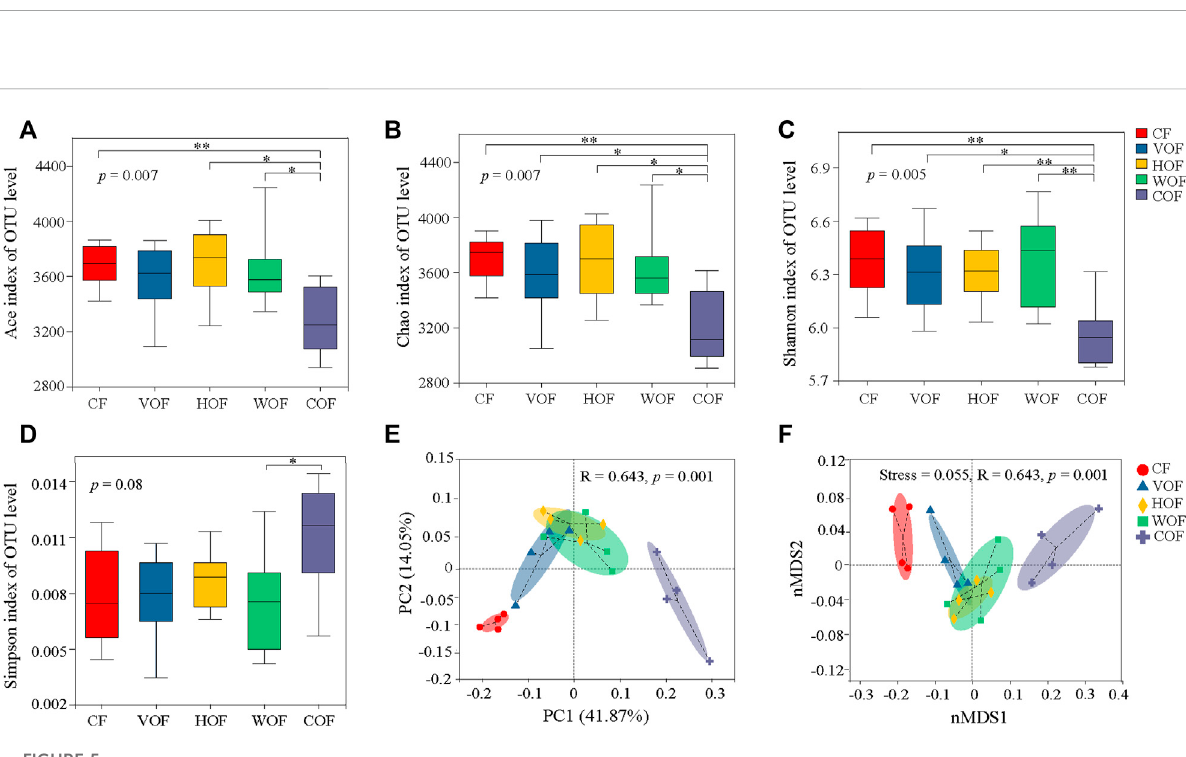
FIGURE 5 Effect of different fertilizers on bacterial community structure in the rhizosphere soil. Ace index (A) , Chao index (B) , Shannon index (C) , and Simpson index (D) of bacteria. * and ** indicate statistical signi fi cance at p < 0.05 and p < 0.01 based on the Wilcoxon rank-sum test, respectively. Principal coordinate analysis (PCoA) (E) and non-metric multidimensional scaling (nMDS) (F) of bacterial community on OTUs level based on Bray- Curtis distance. CF, VOF, HOF, WOF, and COF represent the treatments of tobacco-special chemical fertilizer, vermicompost-based, humic acid-based, wood biochar-based, and compound functional organic fertilizers,